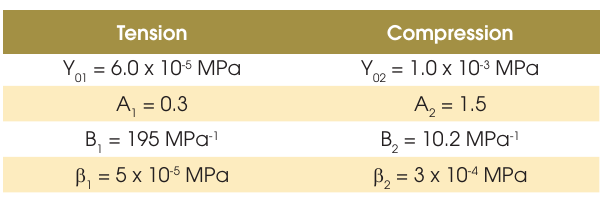
Table 3 – Parameter values of the proposed damage model – RC